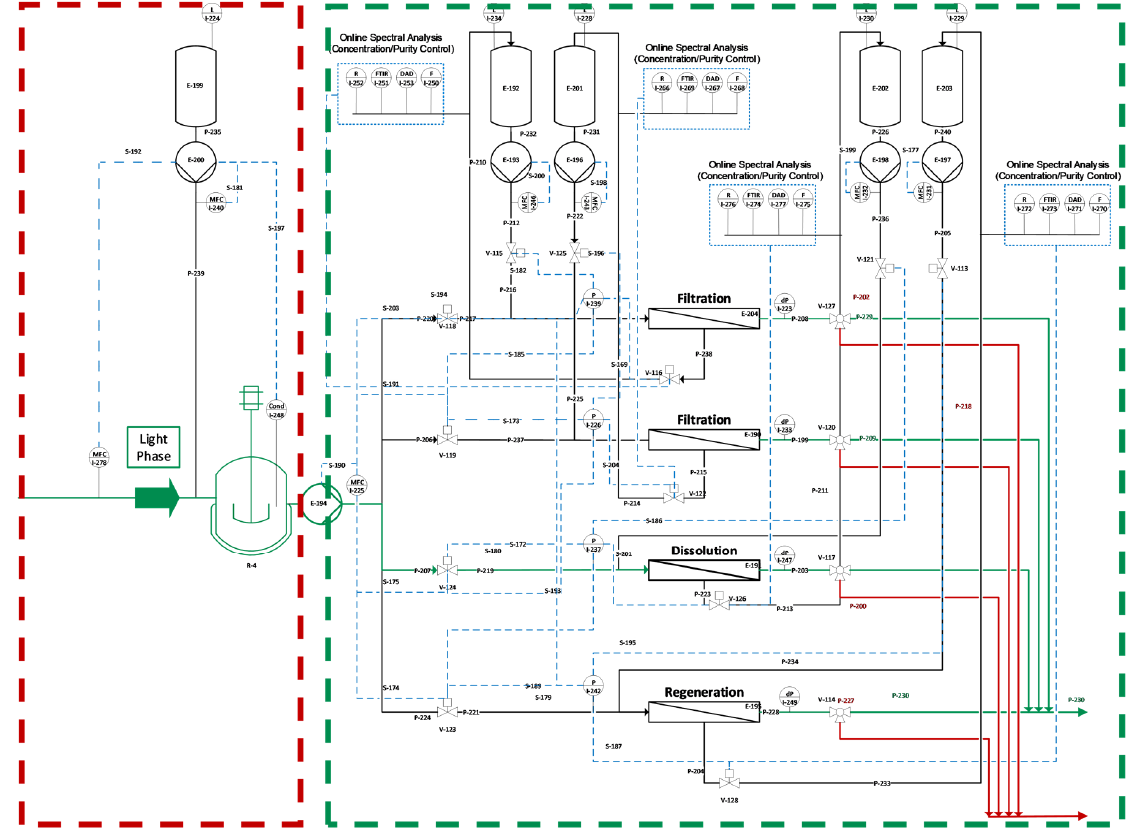
Figure 19. Process control strategy for precipitation. A PAT measurement array at the outlet of the ATPE forwards mAb and side component concentrations to the precipitation unit, which adjusts filtration and dissolution times to obtain a constant mAb concentration in the dissolution